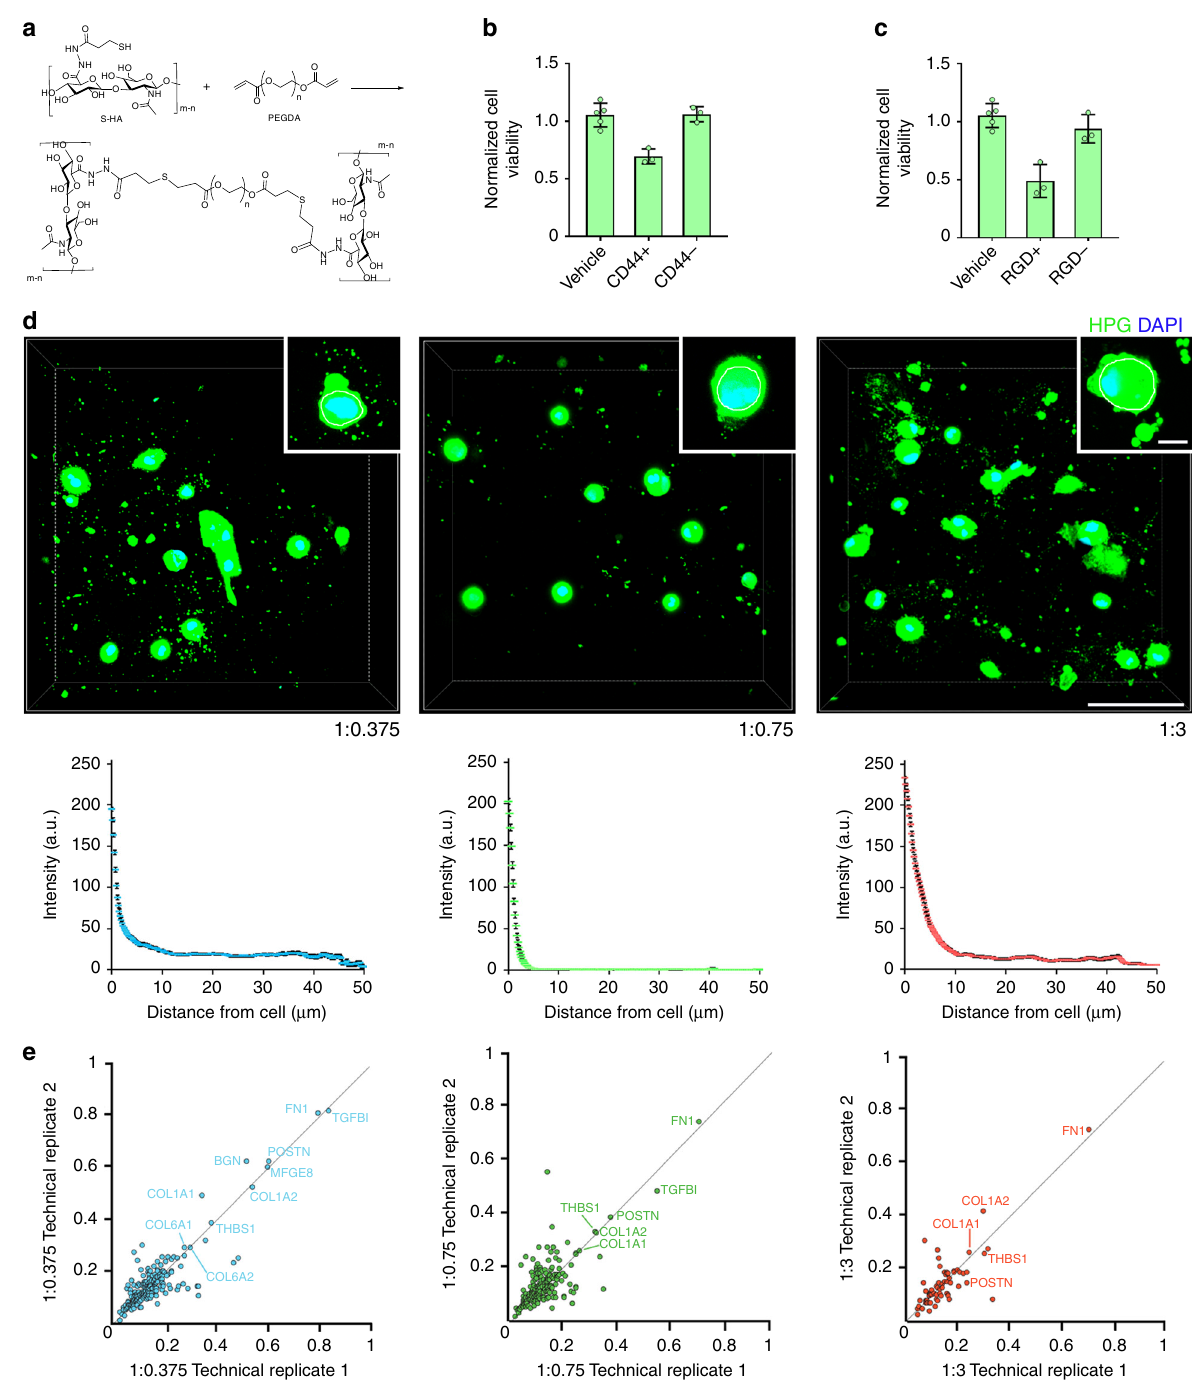
Fig. 1 hMSC within S-HA-PEGDA hydrogels synthesize and secrete proteins pericellularly. a Reaction scheme for hydrogel formation. Thiol-modi fi ed hyaluronic acid (S-HA) cross-links with poly(ethylene glycol) diacrylate (PEGDA) to form a hydrogel via a Michael addition. b Viability of hMSC encapsulated in 1:0.75 hydrogels treated with an anti-CD44 (CD44 + ) antibody or an isotype control (CD44 − ) for 24 h and normalized to vehicle controls ( n ≥ 3). c Viability of hMSC encapsulated in 1:0.75 hydrogels treated for 24 h with RGD sequence-containing peptides (RGD + ) or scrambled peptides (RGD − ) and normalized to vehicle controls ( n ≥ 3). In b and c plots show means± s.d. d Representative micrographs showing fl uorescence labeling of the methionine analogue L -homopropargylglycine (HPG, green) in hMSC-laden 1:0.375, 1:0.75, and 1:3 hydrogels after 72 h in culture. The cell membrane, as determined by differential interference contrast (DIC) imaging, is outlined in white. Scale bar = 100 µ m, inset = 10 µ m. Plots show mean intensity of the fl uorescence signal (±s.e.m.) as a function of distance from the cell membrane in 1:0.375 (blue dashes), 1:0.75 (green dashes), and 1:3 (red dashes) hydrogels and were generated from 40 pro fi le plots collected from 30 cells per condition. e Fraction of SILAC heavy-labeled proteins in decellularized 1:0.375 (blue circles), 1:0.75 (green circles), and 1:3 (red circles) hydrogels cultured for 72 h. Scatterplots show two technical replicates ( H/L count ≥ 3) for each hydrogel composition. Gene names for ECM proteins showing high levels (>40%) of SILAC incorporation are highlighted in each panel